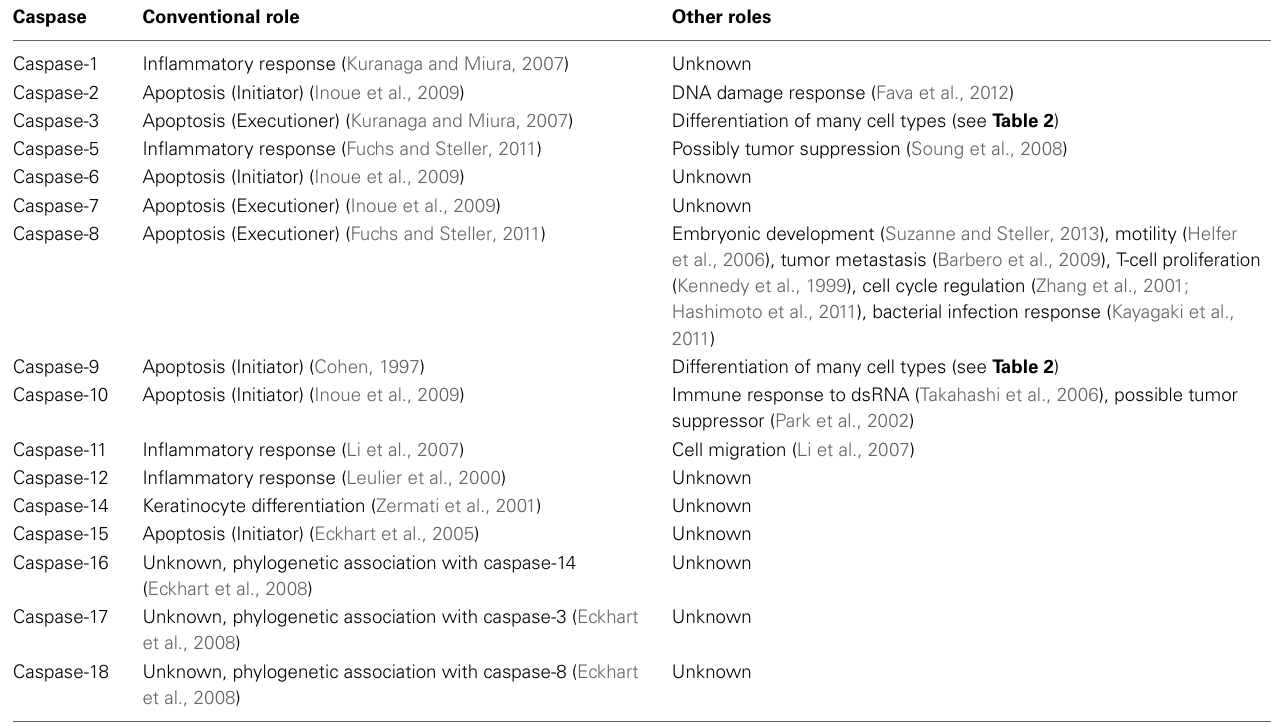
Table 1 | Roles of caspases.